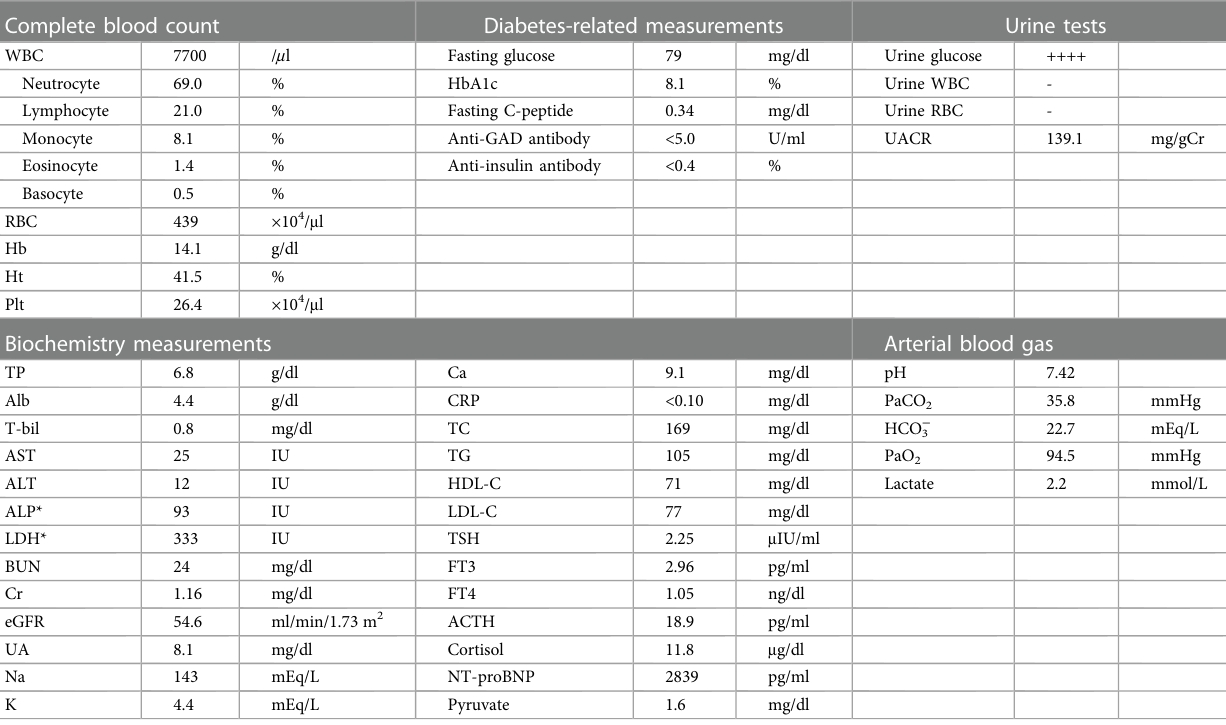
TABLE 1 Laboratory fi ndings on admission. Complete blood count Diabetes-related